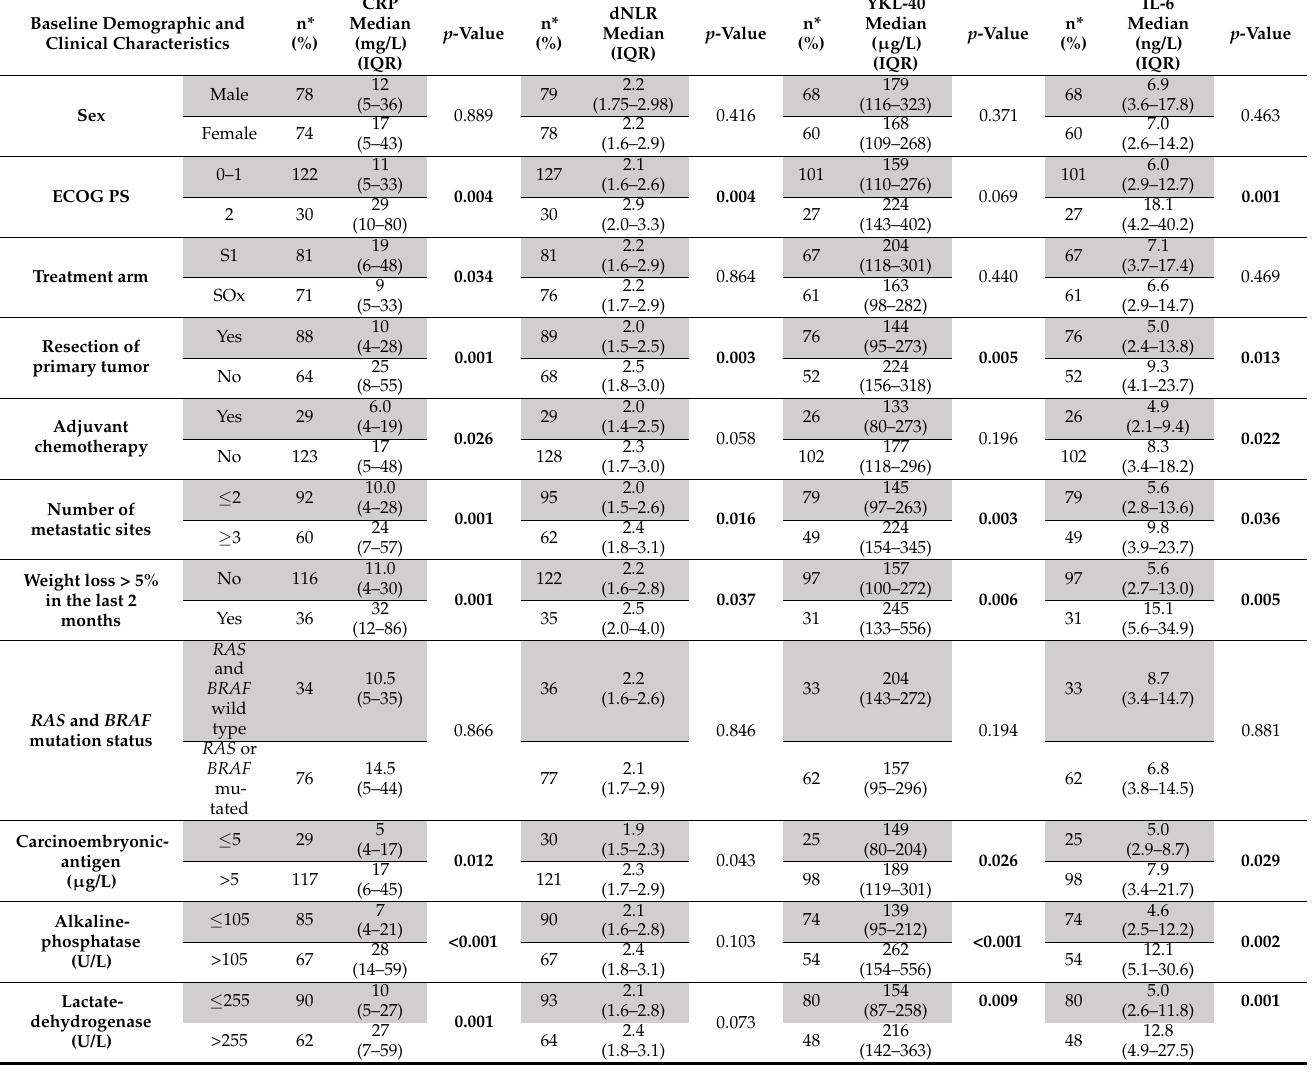
Table 2. Demographic and baseline clinical characteristics in the intention-to-treat population in the NORDIC9-study and their association with pre-treatment plasma CRP, derived neutrophil- lymphocyte ratio, YKL-40, and